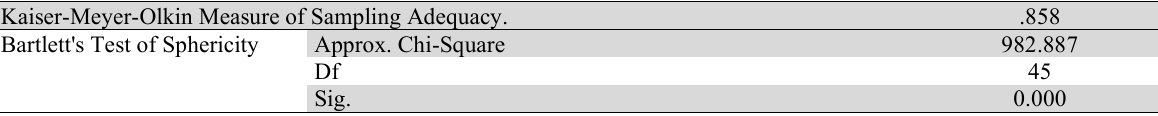
KMO and Bartlett's Test Kaiser-Meyer-Olkin Measure of Sampling Adequacy.